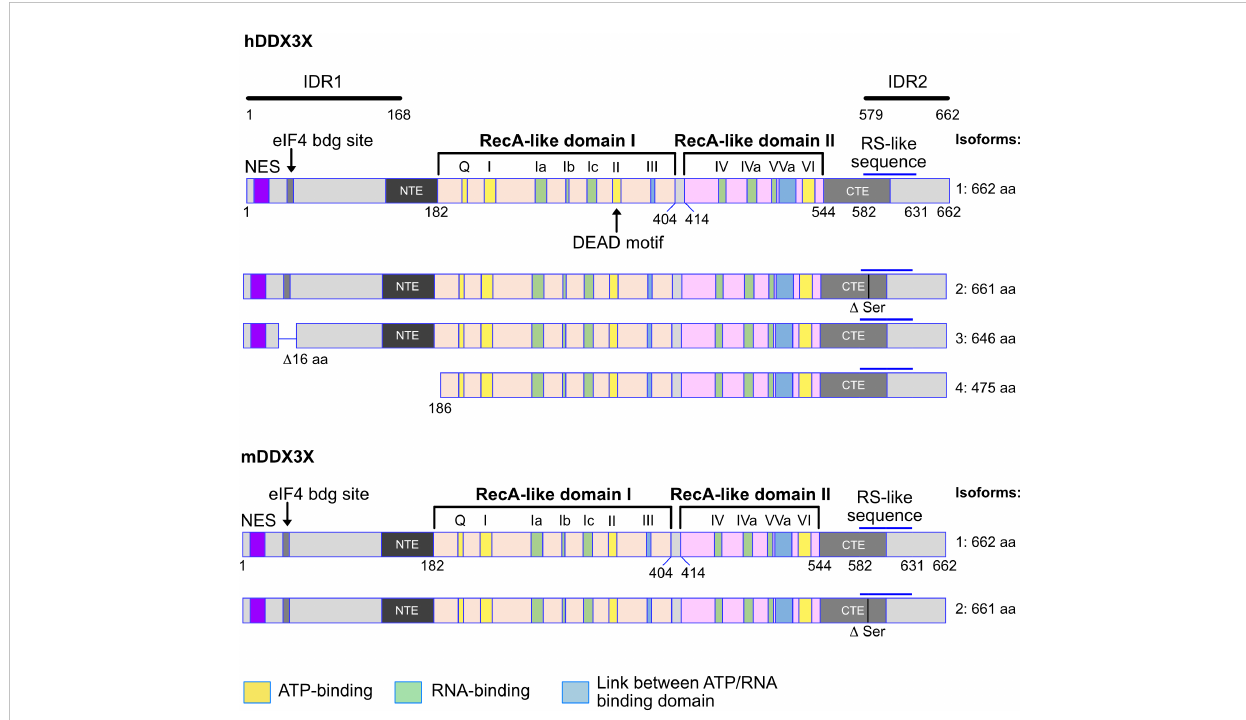
FIGURE 1 Human and murine DDX3X isoforms. Shown are the different isoforms of the human (upper part) and murine (lower part) DDX3X proteins. The variant 4 isoform of the human DDX3X lacks the 185 N-terminal amino acids, creating a protein that does not contain the nuclear export sequence (NES) and may therefore be localized in the nucleus. This is not the case for the murine DDX3X protein isoform. Above the fi rst variant the structure of the DDX3X protein is indicated as well as the different domains and domain groups. NES, nuclear export signal. RS like sequences: RS-like (arginine/serine-like) region that is responsible for interacting with the nuclear export receptor TAP. NTE, N-terminal extension domain; CTE, C- terminal extension domain. IDR1, IDR2, intrinsically disordered regions 1 and 2. Numbers indicate amino acid residues. See text for